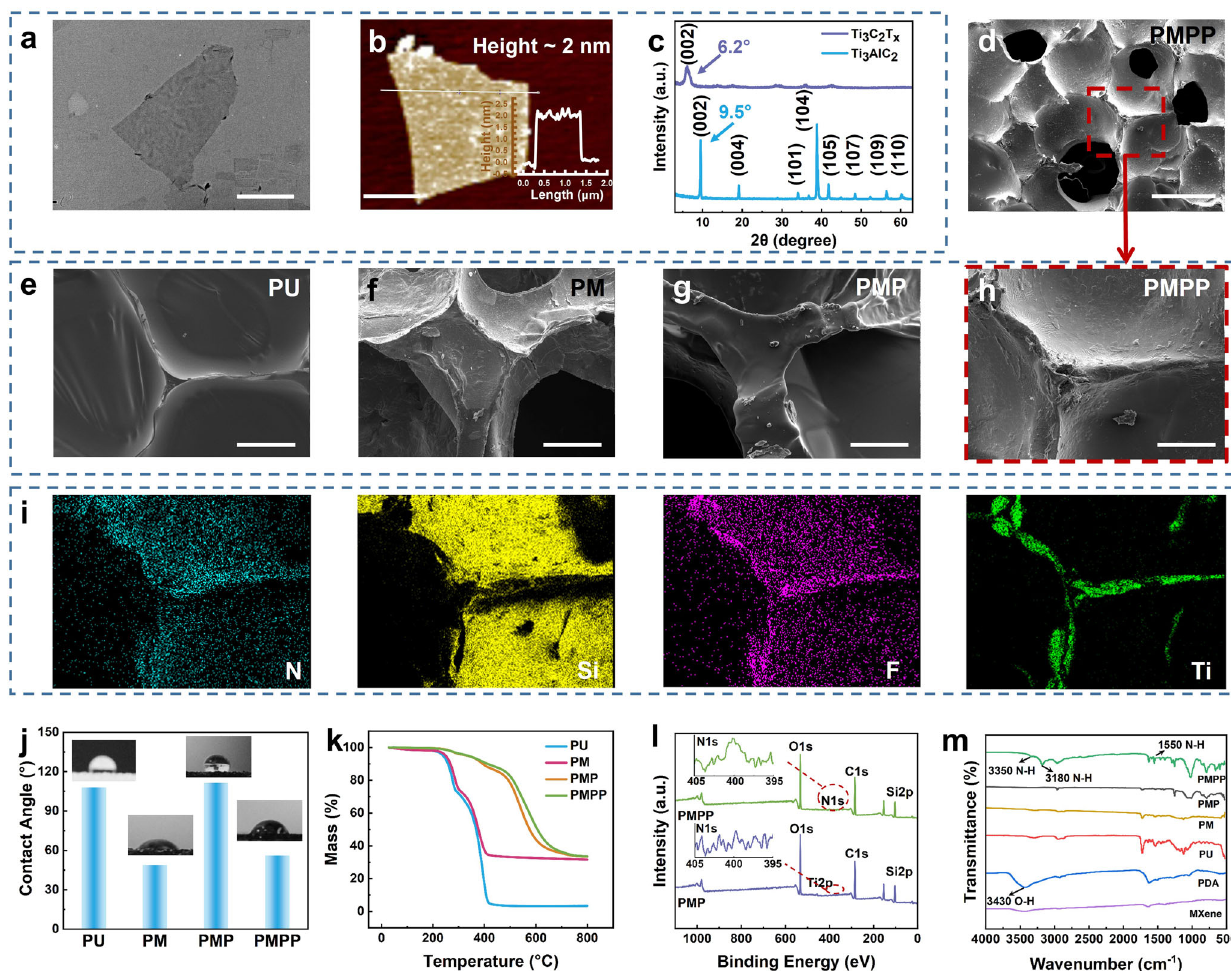
Fig. 2 Characterization of PMPP porous conductive hybrid sponge fi lm. a TEM (Scale bars: 400 nm), b AFM image (Scale bars: 500 nm) and c XRD patterns of MXene nanosheets. d SEM image of PMPP (large view) (Scale bars: 500 μ m). Enlarged SEM images of e PU, f PM, g PMP and h PMPP (Scale bars: 100 μ m). i N-, Si-, F-, and Ti- element mappings of PMPP. j Images and data for water contact angle of PU, PM, PMP, and PMPP. k TGA curves of PU, PM, PMP, and PMPP. l XPS patterns of PMP and PMPP (Inset: details of N1s curves for PMP and PMPP). m FT-IR spectra of MXene, PDA, PU, PM, PMP,